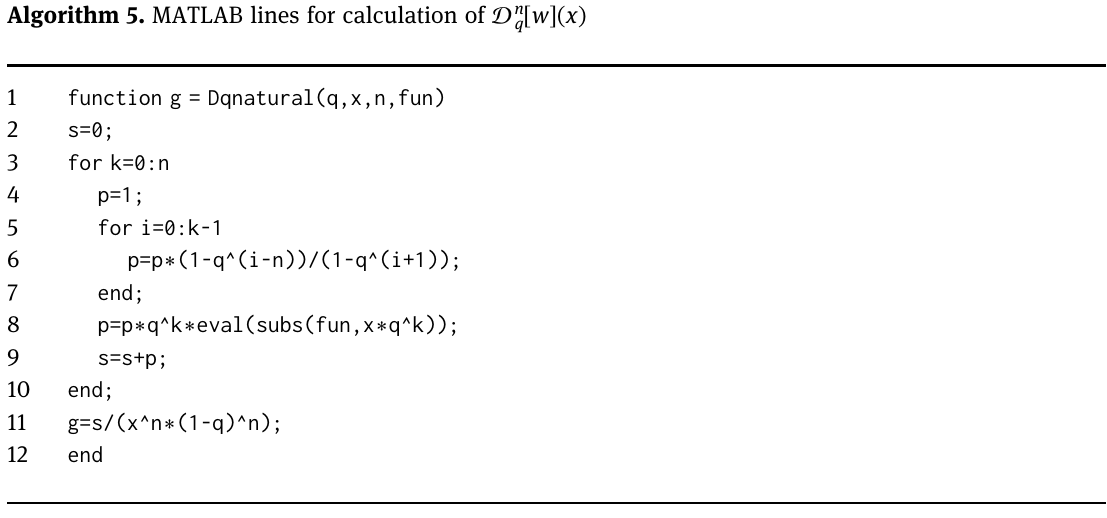
Algorithm 5. MATLAB lines for calculation